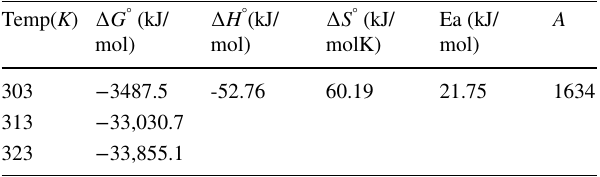
Table 6 Thermodynamic parameters of IBP adsorption onto OPA at different temperatures Temp( K ) ∆ G ° (kJ/